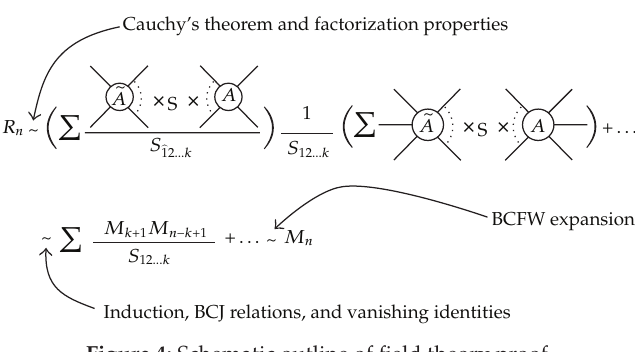
Figure 4: Schematic outline of field theory